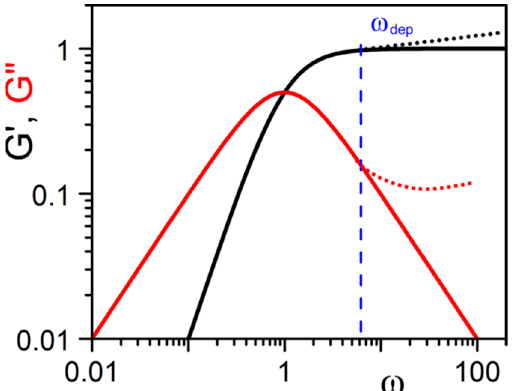
Figure 16 . Solid lines represent the theoretical variation of G ′ and G ″ as a function of frequency from relation 31 . Dotted lines above ω dep stand for the usual experimental departures seen with dynamic polymers for instance [42–44].